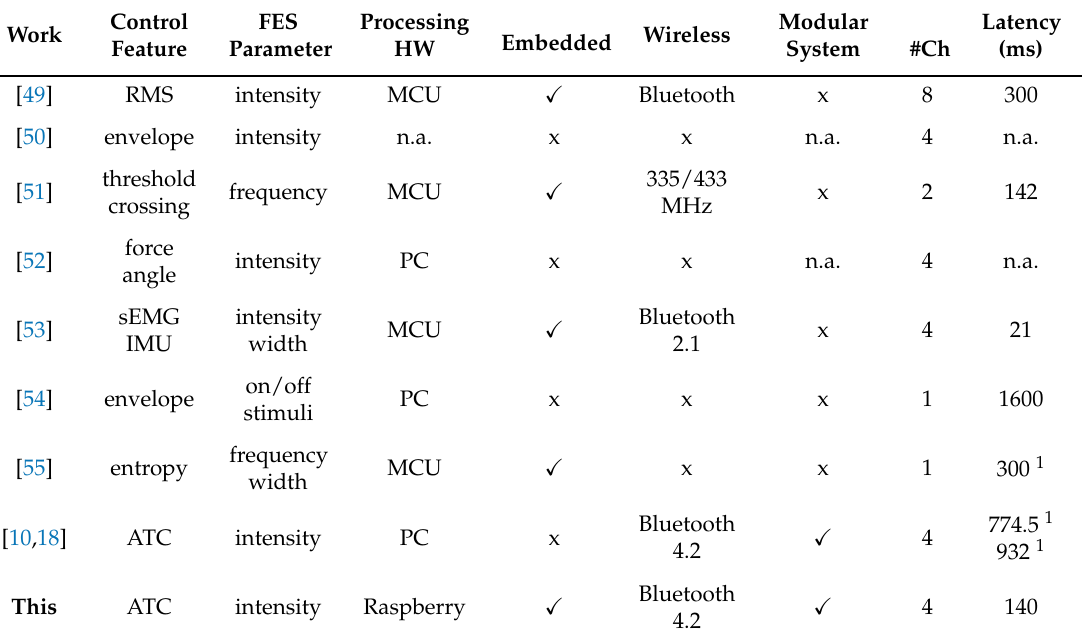
Table 6. sEMG-trigger-FES systems table